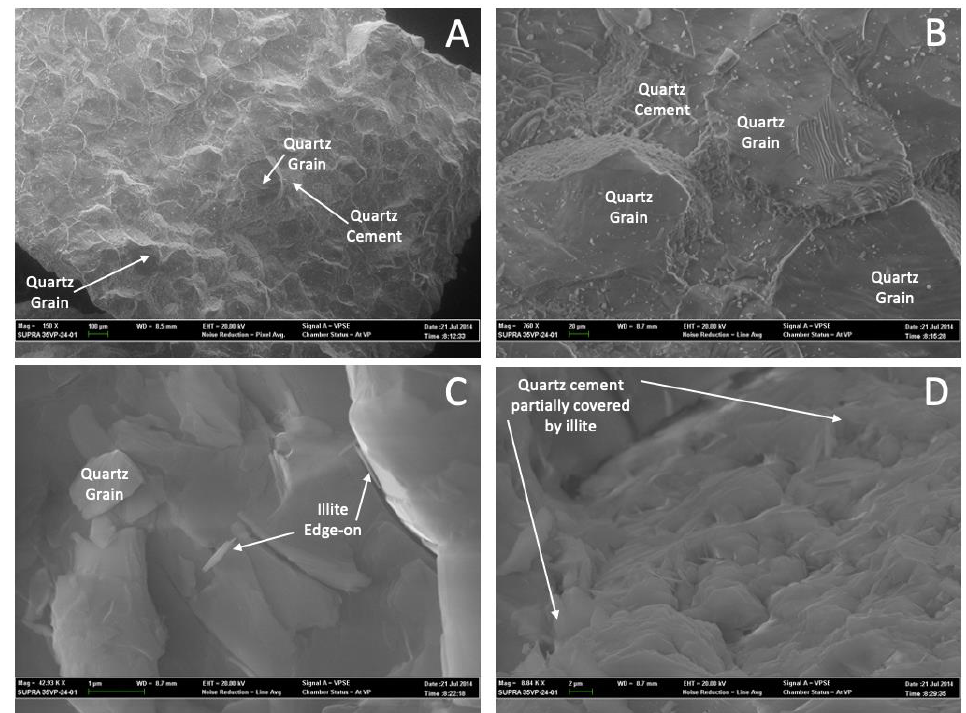
Figure 4. SEM images showing common textures and impurities observed. ( A ) A low magnification image showing quartz grains in quartz cement. Grains vary from approximately 100 to 300 µm in diameter. ( B ) A higher magnification image showing no visible macro porosity between cement and grains. ( C ) A broken surface showing small crystallites of illite on edge on a quartzite cement surface. Illite crystallites are approximately 1 µm in diameter. ( D ) A quartz cement with subhedral crystals partially covered (30%) by illite crystallites that are approximately 2 µm in diameter.